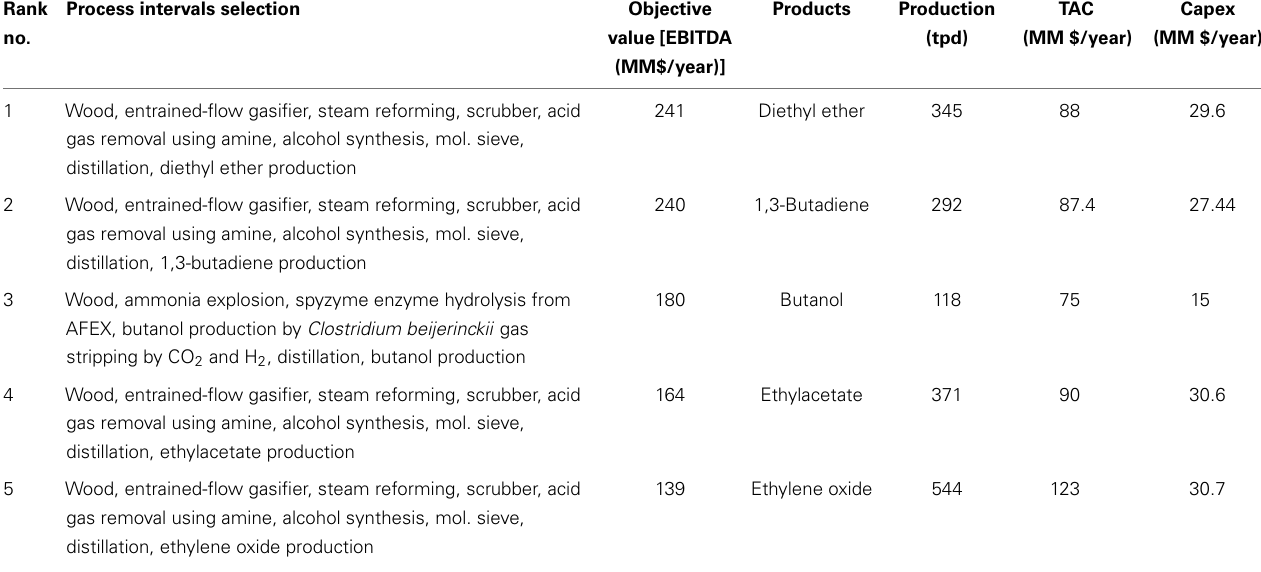
Table 9 |Top-five ranking of the optimal solutions using Model 2 ( + 30 to + 100%) for capital cost estimation (max EBITDA of producing ethanol derivatives)